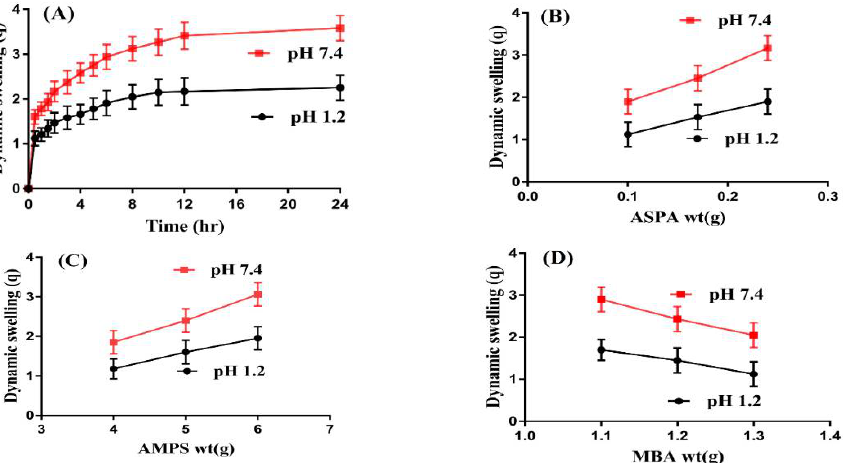
Figure 2. Effectsof( A )pH,( B )ASPA,( C )AMPS,and( D